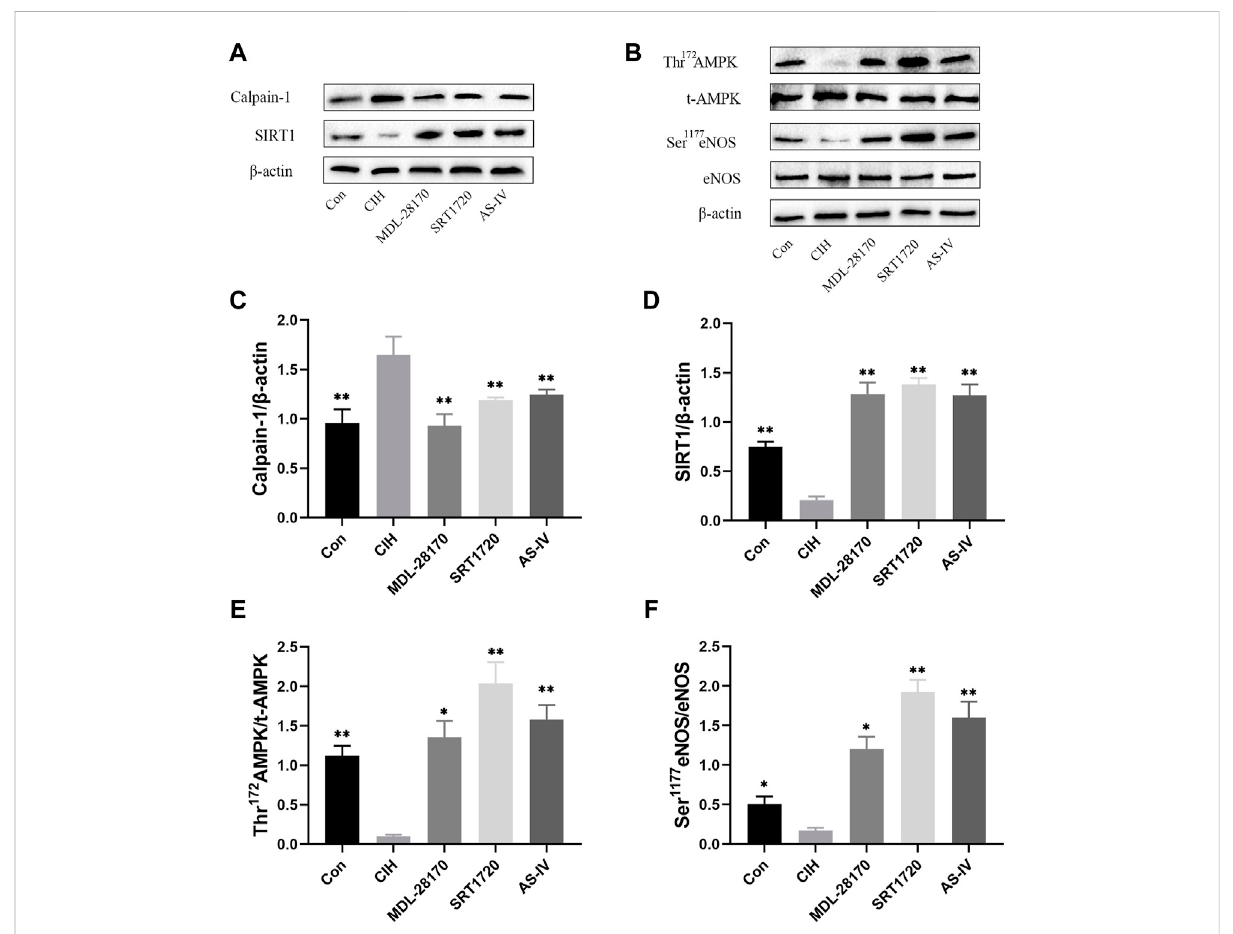
FIGURE 9 Effects of As-IV, MDL-28170 and SRT1720 administration on calpain-1, SIRT1, AMPK, and eNOS protein expression in HCAECs. (A – F) The protein expression levels of calpain-1, SIRT1, Thr 172 AMPK phosphorylation, t-AMPK, Ser 1177 eNOS phosphorylation and eNOS were analyzed using Western blots ( n = 3). Data are presented as means ± SD. ** p < 0.01, *P ＜ 0.05, vs. CIH